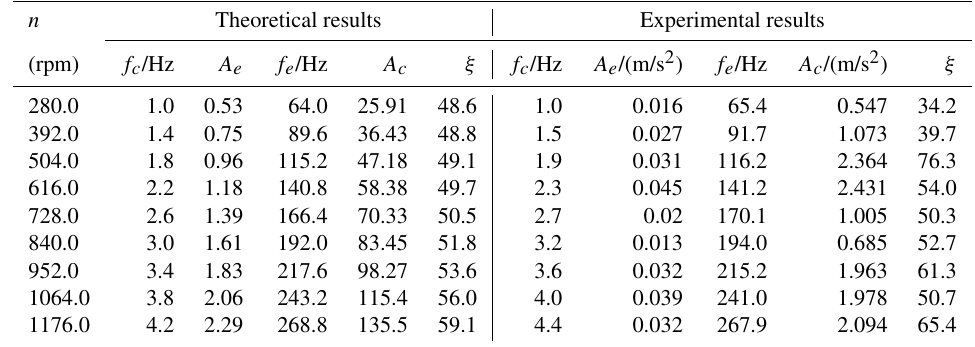
Table 2. Comparison of theoretical and experimental results. n Theoretical results Experimental results